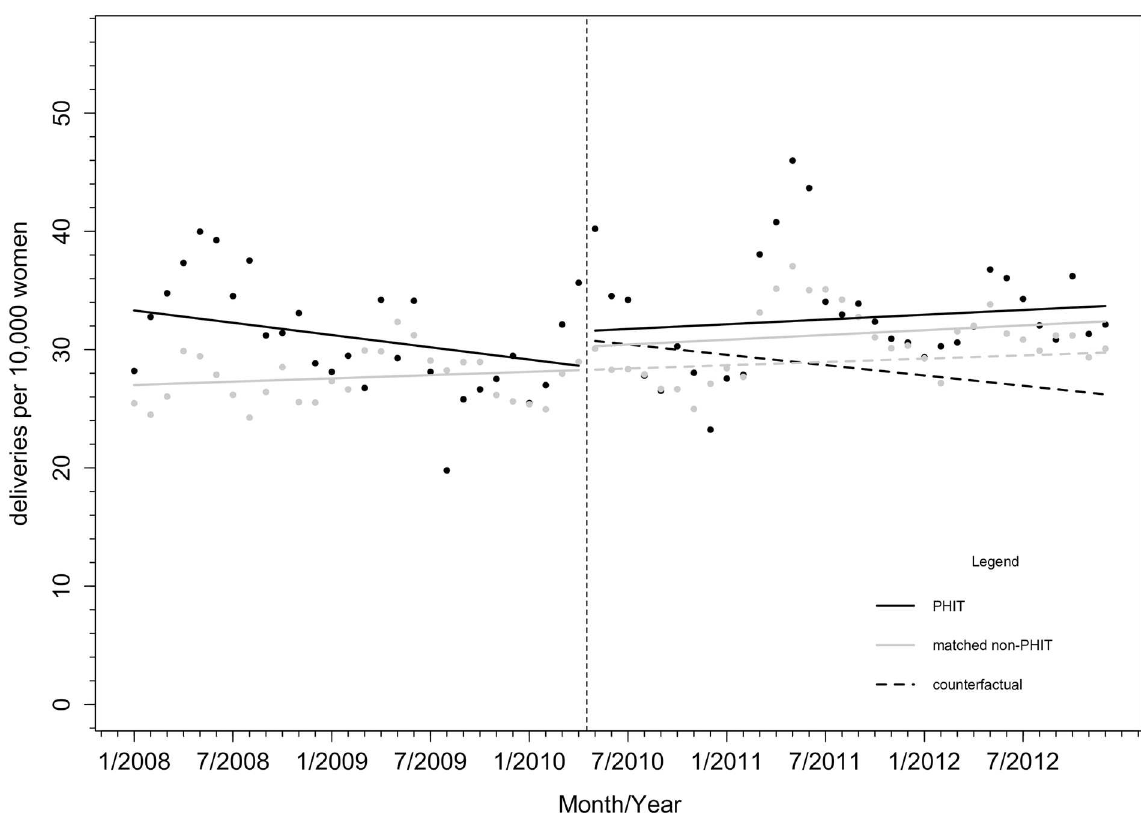
Fig 2. Monthly facility delivery rates (count per 10,000 women in the population) in PHIT health facilities (n = 13) or comparison propensity score matched facilities (n = 86). Notes: Vertical line indicatesstart of PHIT HSS interventionin May